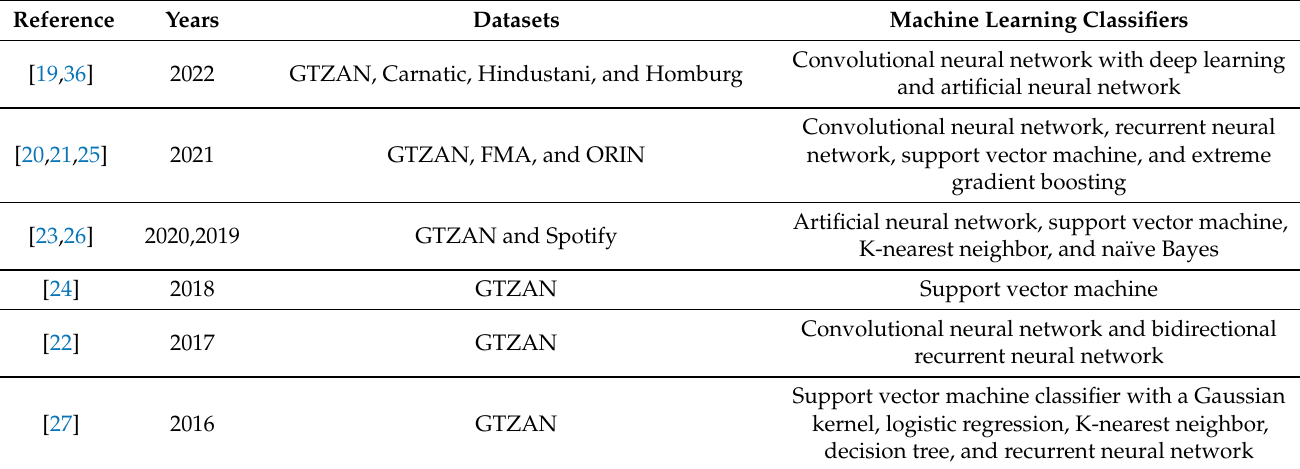
Table 1. A summary of literature review on the datasets and machine learning